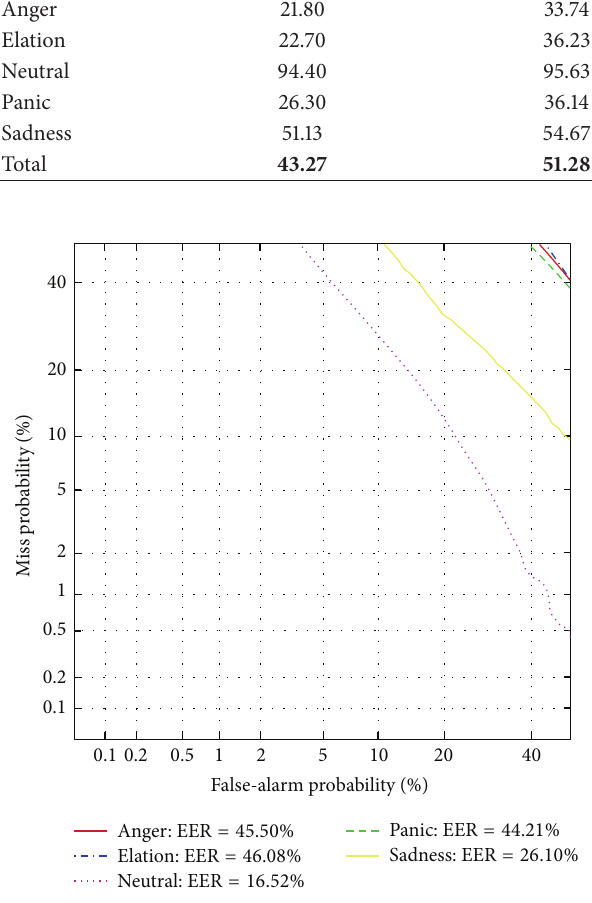
Figure 4: DET curves for the traditional speaker models trained with neutral speech only.